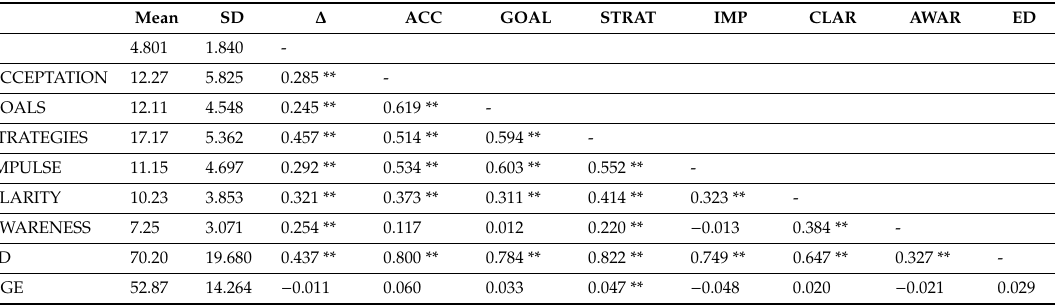
Table 4. Pearson correlations of ∆ / DERS /